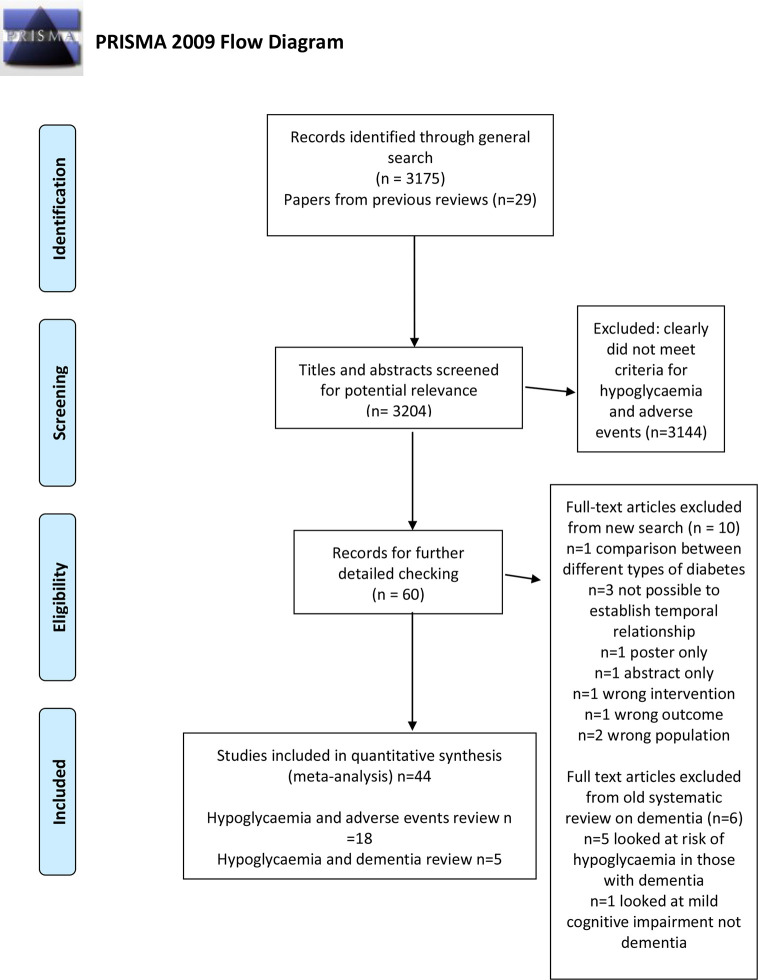
PRISMA flow chart.